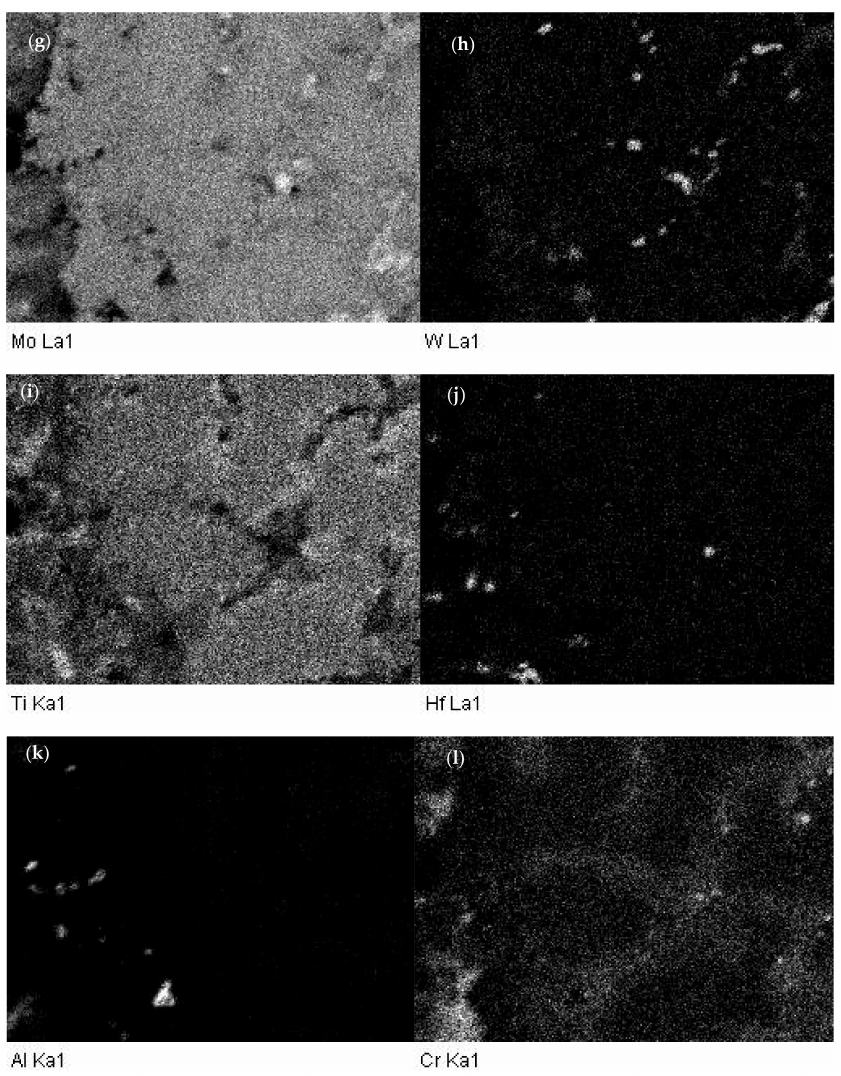
Figure 7. X-ray maps of a cross section of the oxidized specimen of JZ4 at 1200 ◦ C, where: ( b ) Oxygen; ( c ) Ge; ( d ) Sn; ( e ) Si; ( f ) Nb; ( g ) Mo; ( h ) W; ( i ) Ti; ( j ) Hf; ( k ) Al; ( l )